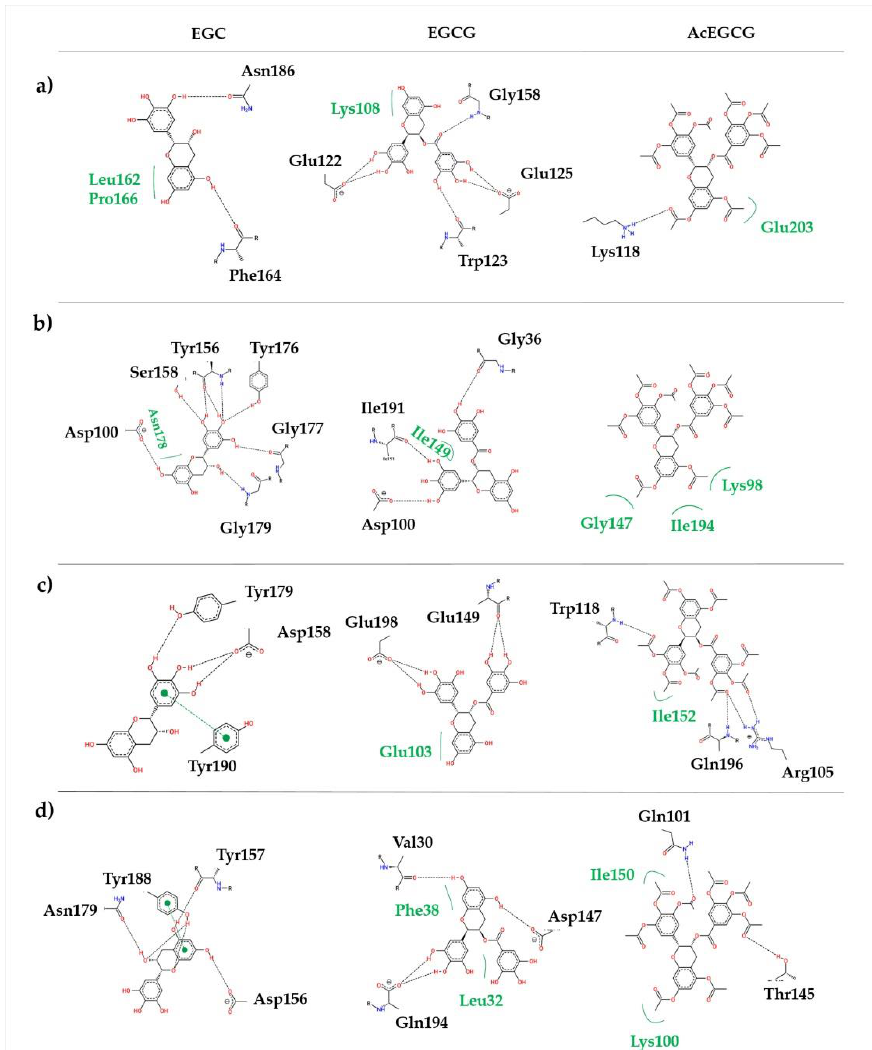
Figure 2. Epigallocatechin molecules binding mode and conformation of the representative complex. ( a ) DENV, ( b ) YFV, ( c ) WNV, and ( d ) ZIKV. NS2B/NS3 pro adopts a chymotrypsin-like fold with a catalytic triad composed of His51, Asp75, and Ser135 in the cleft between two ß-barrels. Despite the low sequence